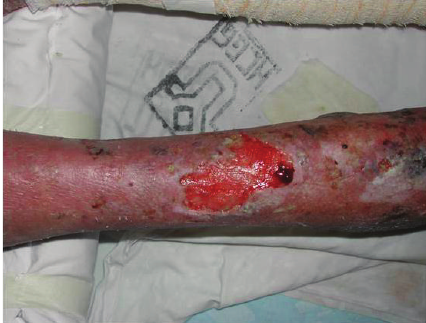
Figure 2: Desquamative and nonpruritic lesions in face.